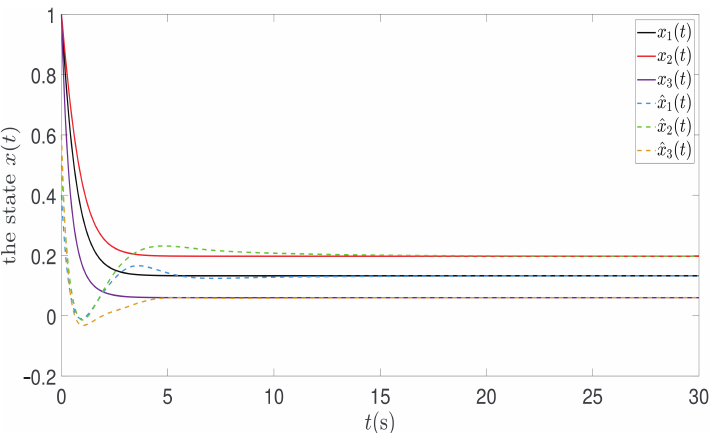
Figure 13. The state and estimated state curves of the 3-dimensional memristor neural networks.